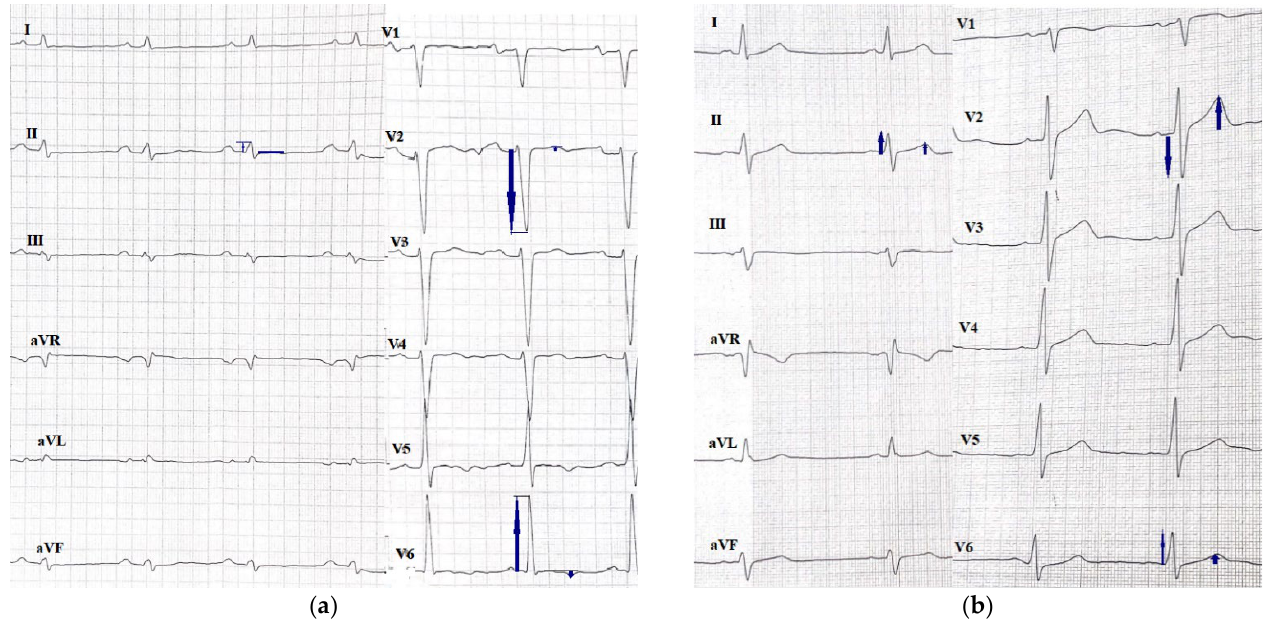
Figure 2. ECGs of patients with DCM with ( a ) an abnormal QRS-T angle of 164° and ( b ) a normal QRS-T angle of 88° . QRS-T angle of 88 ◦